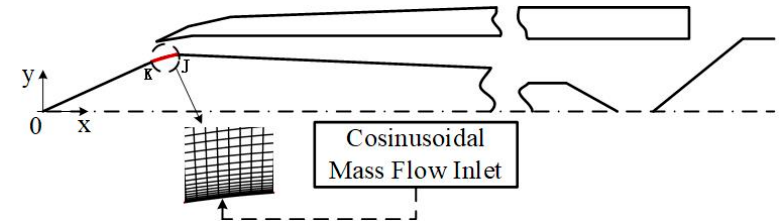
Figure 15. Location of small perturbation jet slot.